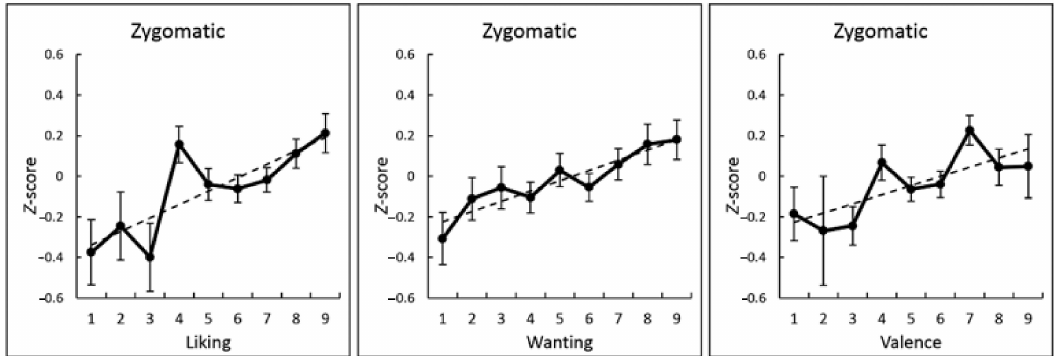
Figure 3. Group-mean (with standard error) values (dots) and regression lines (dashed lines) of subjective ratings (liking, wanting, and valence) and zygomatic major electromyography activity (standardized for each individual).